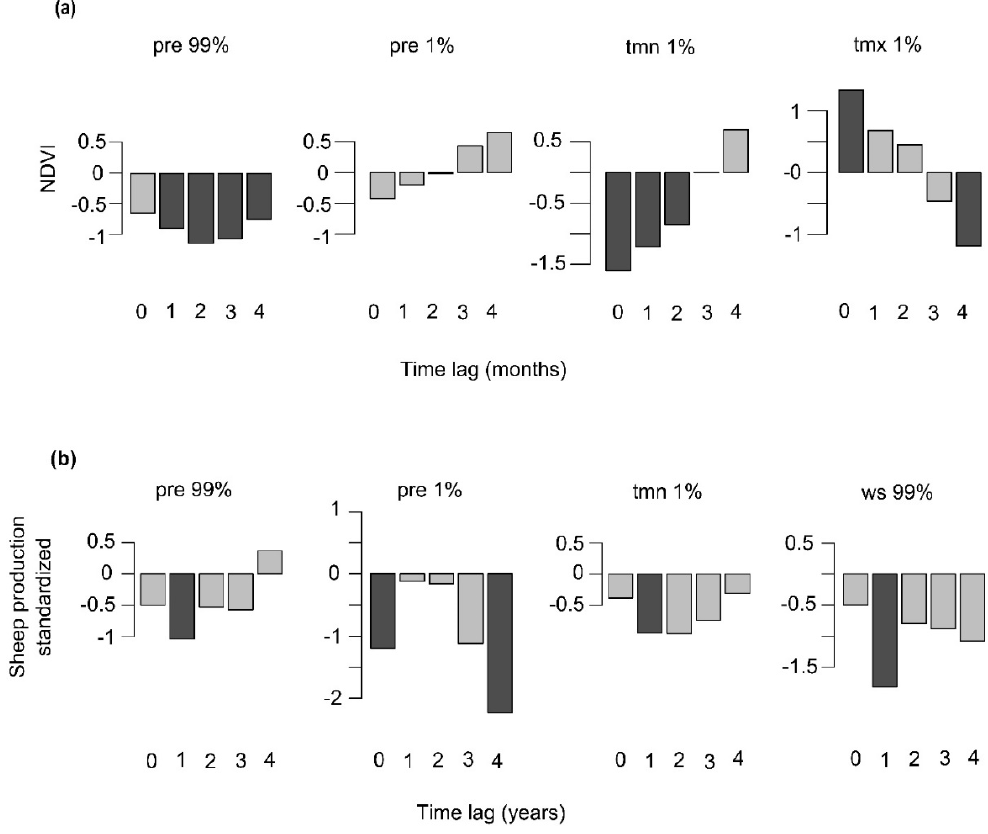
Figure 7. Superposed epoch analysis (SEA) comparing the e ff ect of extreme weather events on ( a ) NDVI time series from 1985 to 2018, and ( b ) SP time series from 1987 to 2019. The black bars indicate values significant at the p < 0.05 level. Plot labels pre 99% and pre 1% represent EE defined by precipitation values above the 99th percentile and below the 1st percentile, respectively; tmn 1% represents EE defined by minimum temperature values below the 1st percentile; ws 99% represents EE defined by wind speed values above the 99th percentile; and tmx 99% represents EE defined by maximum temperature values above the 99th percentile.